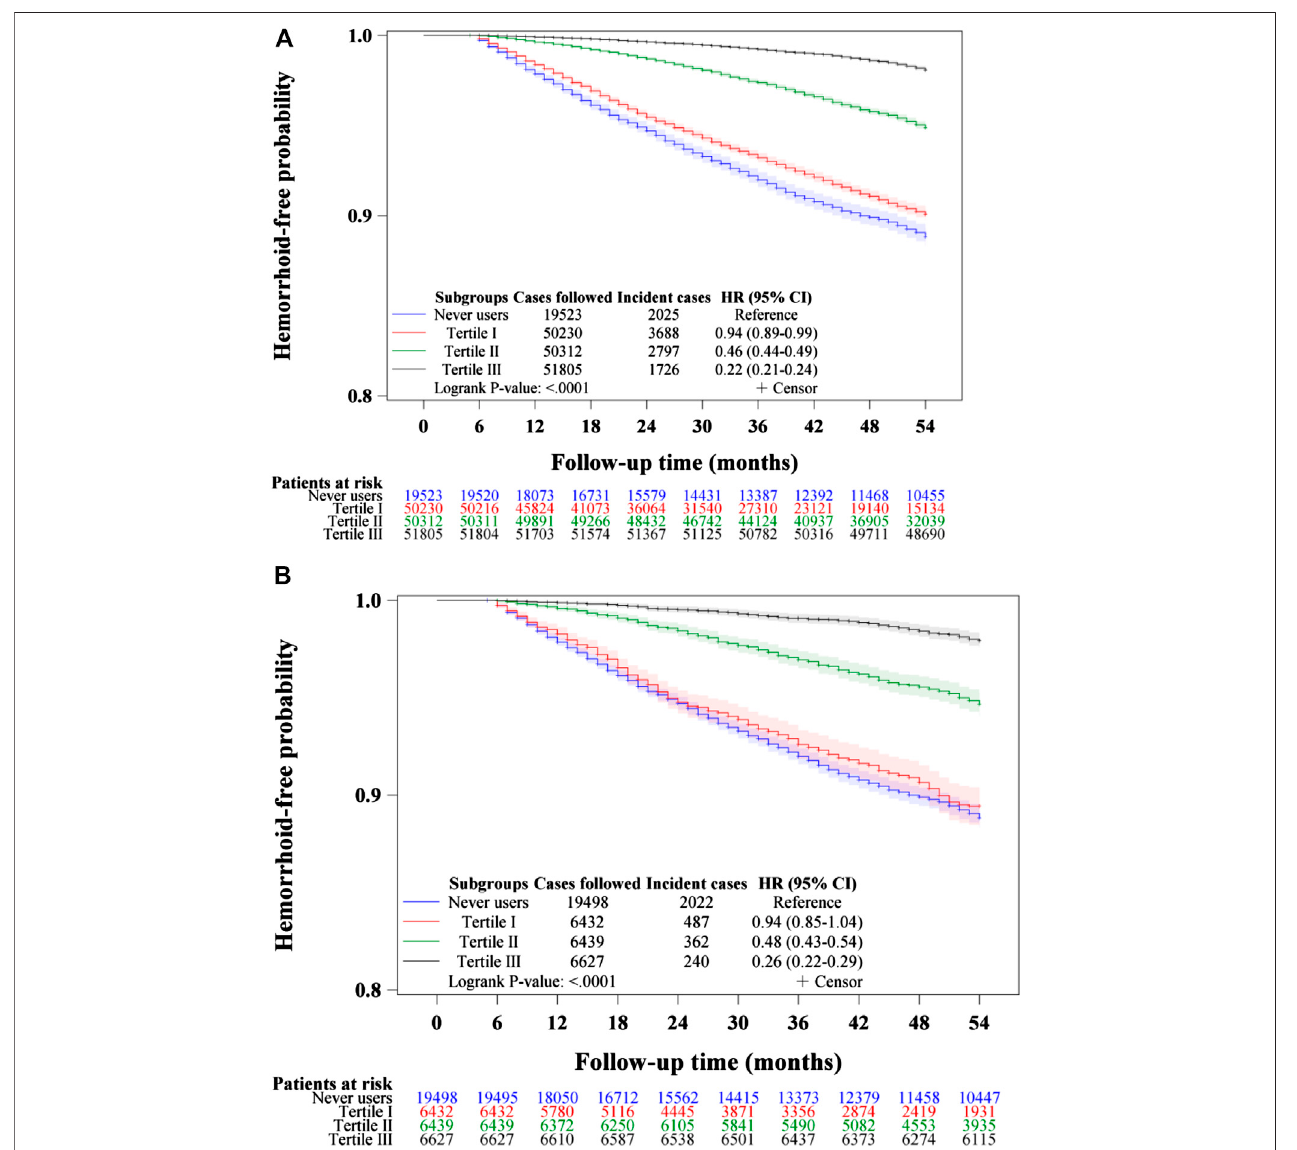
FIGURE 3 | Kaplan – Meier curves comparing hemorrhoid-free probability among never users and tertiles of cumulative duration of metformin therapy in the unmatched cohort (A) and the matched cohort (B) , respectively. HR: hazard ratio, CI: con fi dence interval.